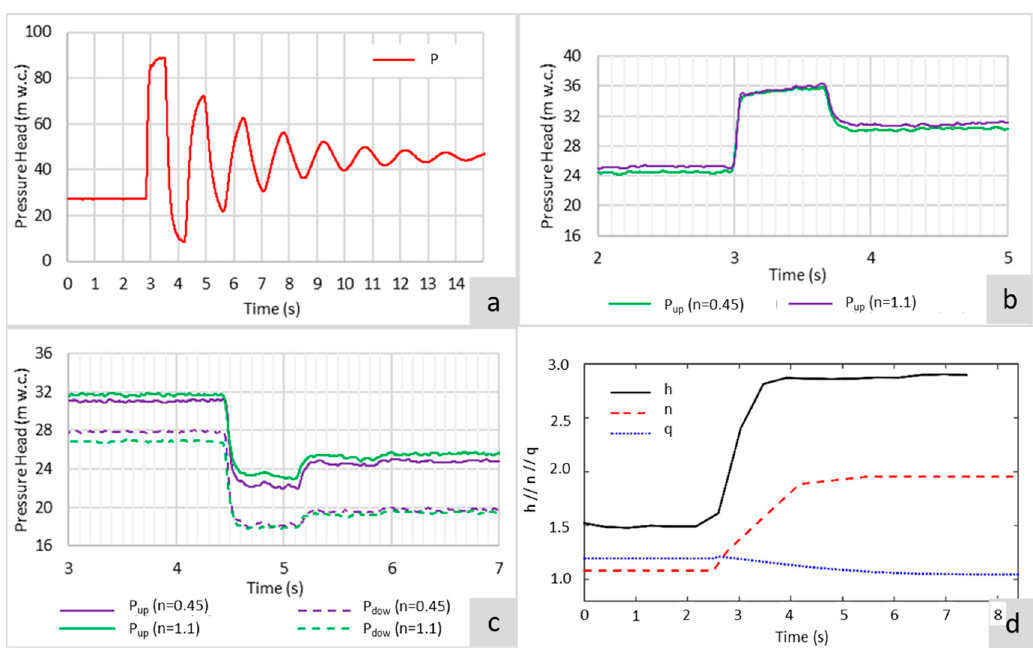
Figure 9. Experimental transient regimes: ( a ) upstream pressure when all hydrant outlets have a fast closure manoeuvre; ( b ) upstream pressure when three outlets are closed very fast, and the PAT for different ‘ n ’ values; ( c ) upstream and downstream pressure when three outlets are opened rapidly, and the PAT for different ‘ n ’ values; ( d ) runaway conditions for q = 1.1 at instant 2.3 s.